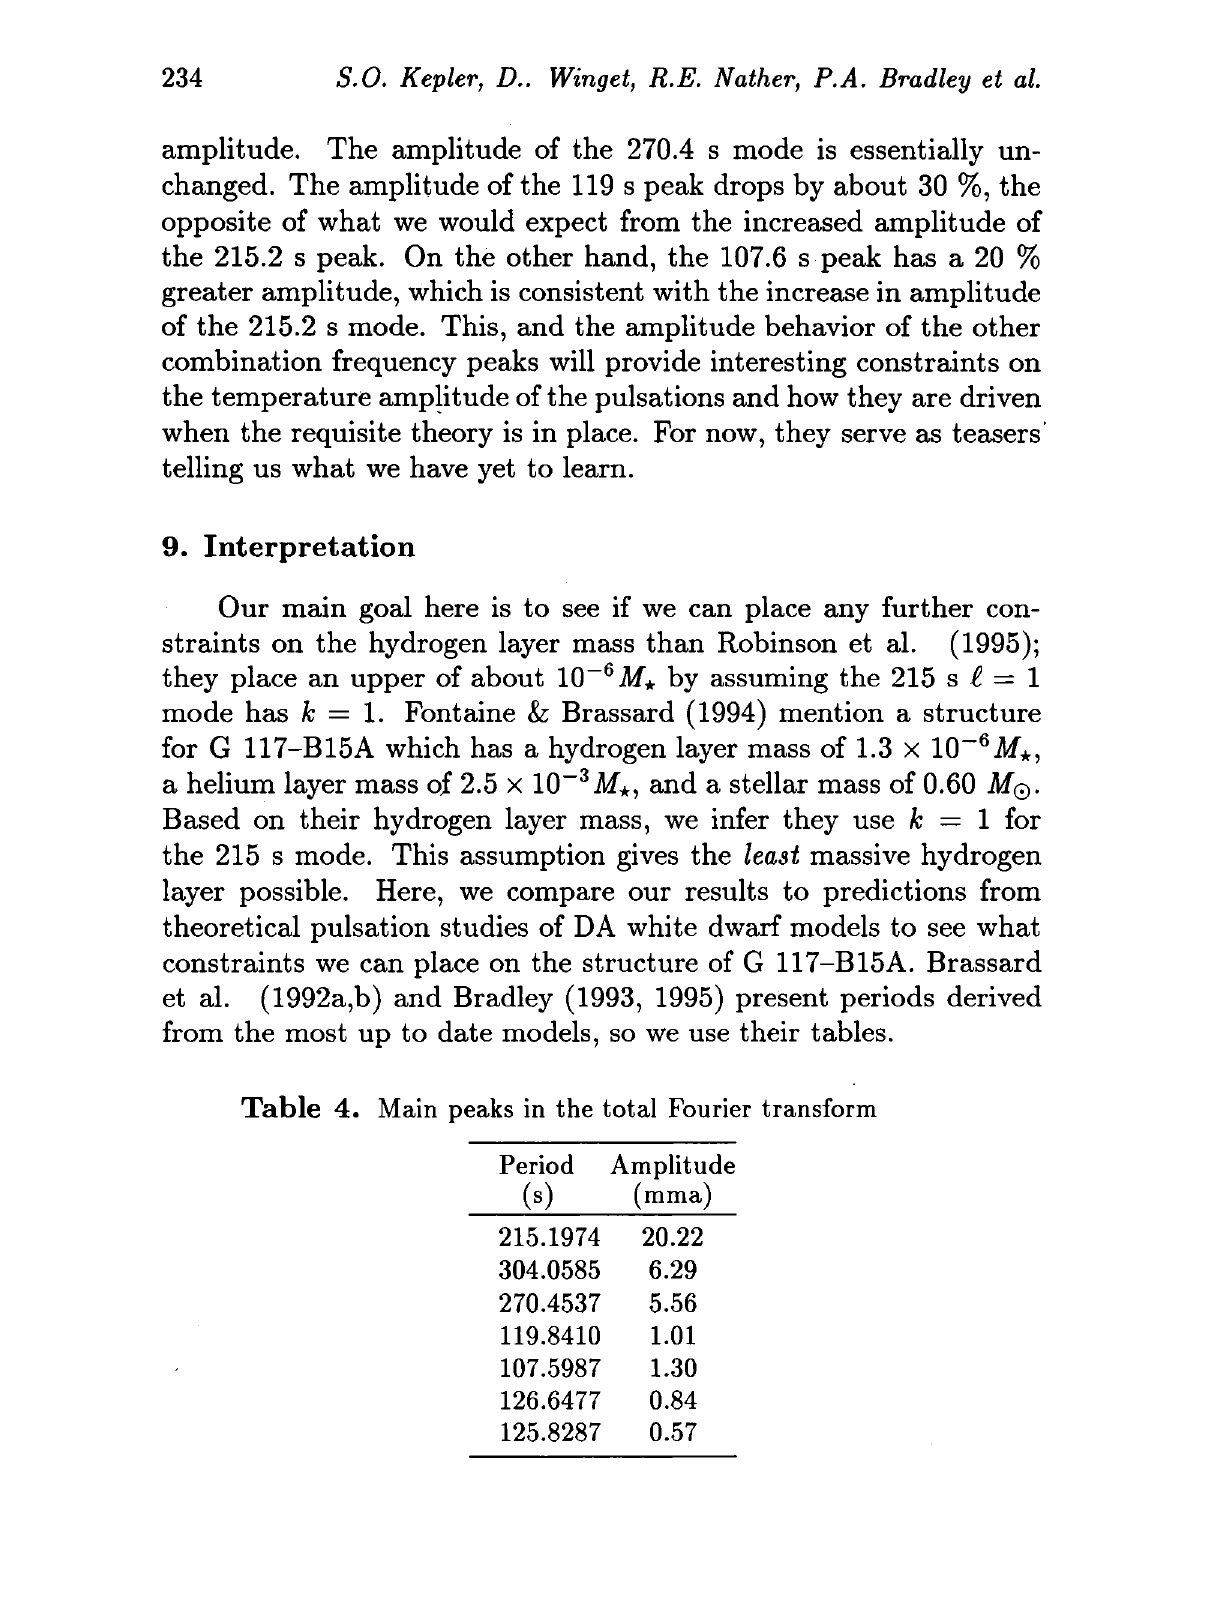
Table 4. Main peaks in the total Fourier transform